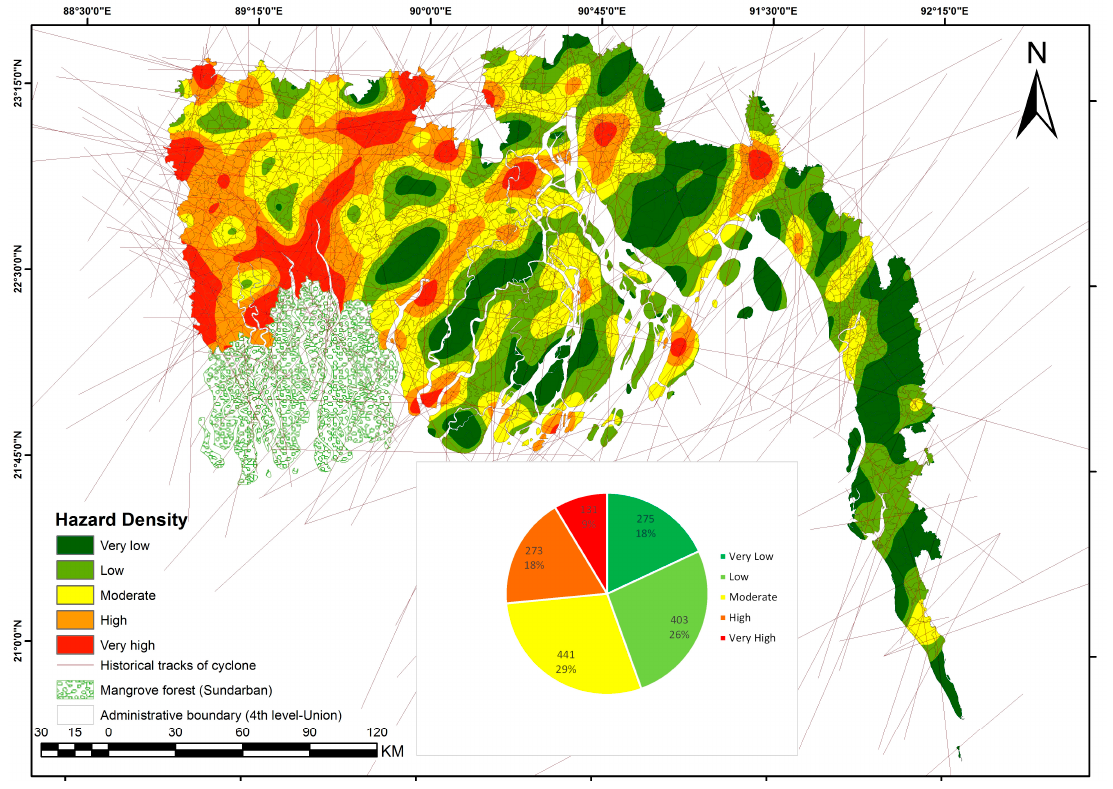
Figure 7. Hazard map of the study area. Cyclone hazard density was calculated by using cyclone tracks considering all cyclone categories that crossed Bangladesh in the period 1877–2015. Data have been compiled from NOAA IBTrACS (International Best Track Archive for Climate Stewardship), Global Risk Data Platform of UNISDR, Bangladesh meteorological department and published cyclone map of Banglapedia.